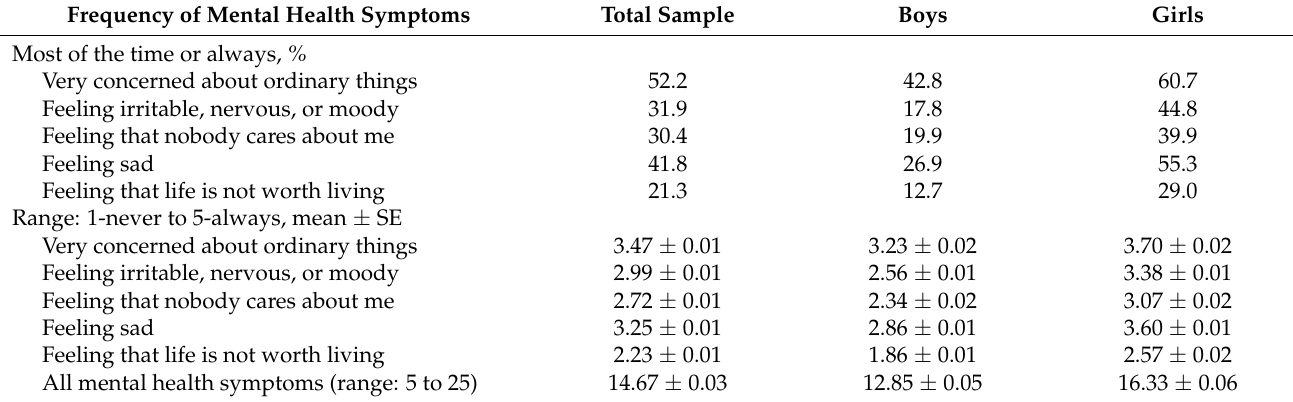
Table 2. Mental health symptoms of adolescent students aged 13–17 years by sex, Brazil, 2019.